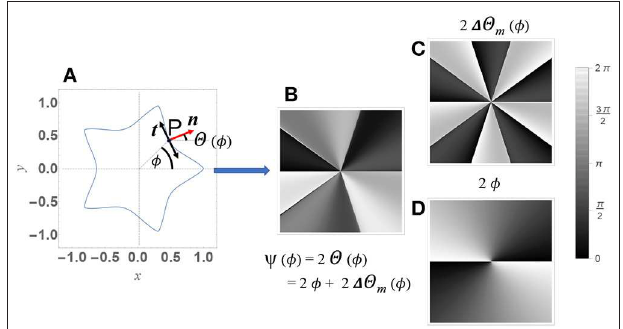
FIGURE 1 | Schematic of the encryption procedure of the symmetry properties of a plane curve into the azimuthal phase of a light beam. In (A) , as an example, we show t and n , i.e., the tangent and the normal unit vectors to the curve at the point P , respectively. n forms an angle 2 ( φ ) with the horizontal axis. In (B) , we show the transverse phase profile ψ ( φ ) 2 2 ( φ 1,1,5,1 / 2,4 / 3,4 / 3) (Equation 6). The latter can be regarded as = ; the superposition of the phase modulation 2 12 m ( φ ) (C) and the helical phase profile 2 φ (D)